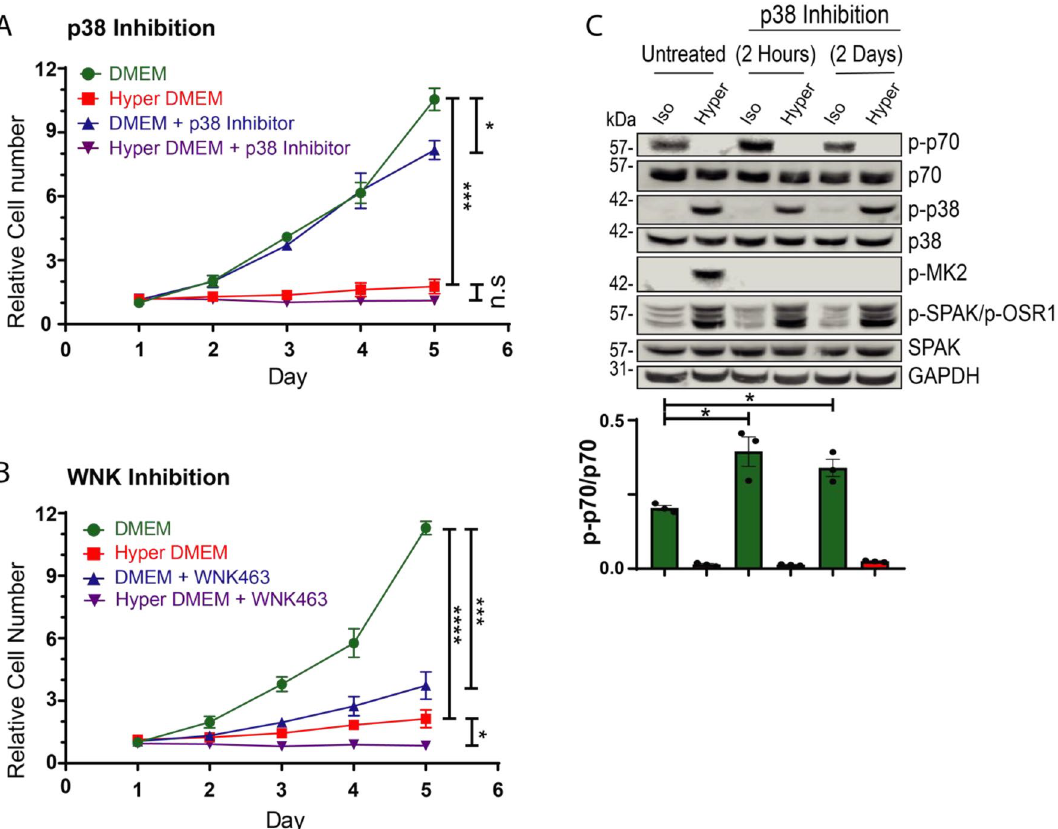
Figure 7. The effect of p38, WNKs and hyper-osmolarity on cell proliferation and mTORC1 activation. HeLa cells were treated with either iso- or hyper- osmotic cellular medium with or without ( A ) 5 μM SB203580 (p38 inhibitor), or ( B ) 10 μM WNK463 (pan-WNK inhibitor). Cell proliferation (cell count) was measured over the course of 5 days using a Coulter Counter, and normalized to Day 1. ( C ) HeLa cells were treated with 5 μM SB203580 for 2 h or 2 days and followed by incubation with iso- or hyper- osmotic DMEM (+ serum) for 15 min. in the presence/absence of SB203580. Quantification of active p70 S6K (p-p70) is depicted below the respective blots. All data are mean ± s.e.m, ( N = 3 independent experiments). Statistics as described in Fig.